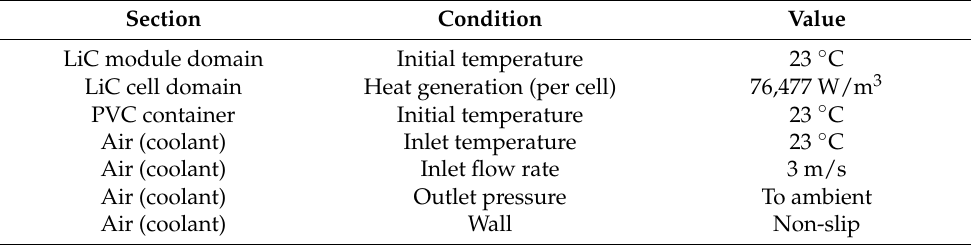
Table 3. Initial conditions and boundaries of the CFD